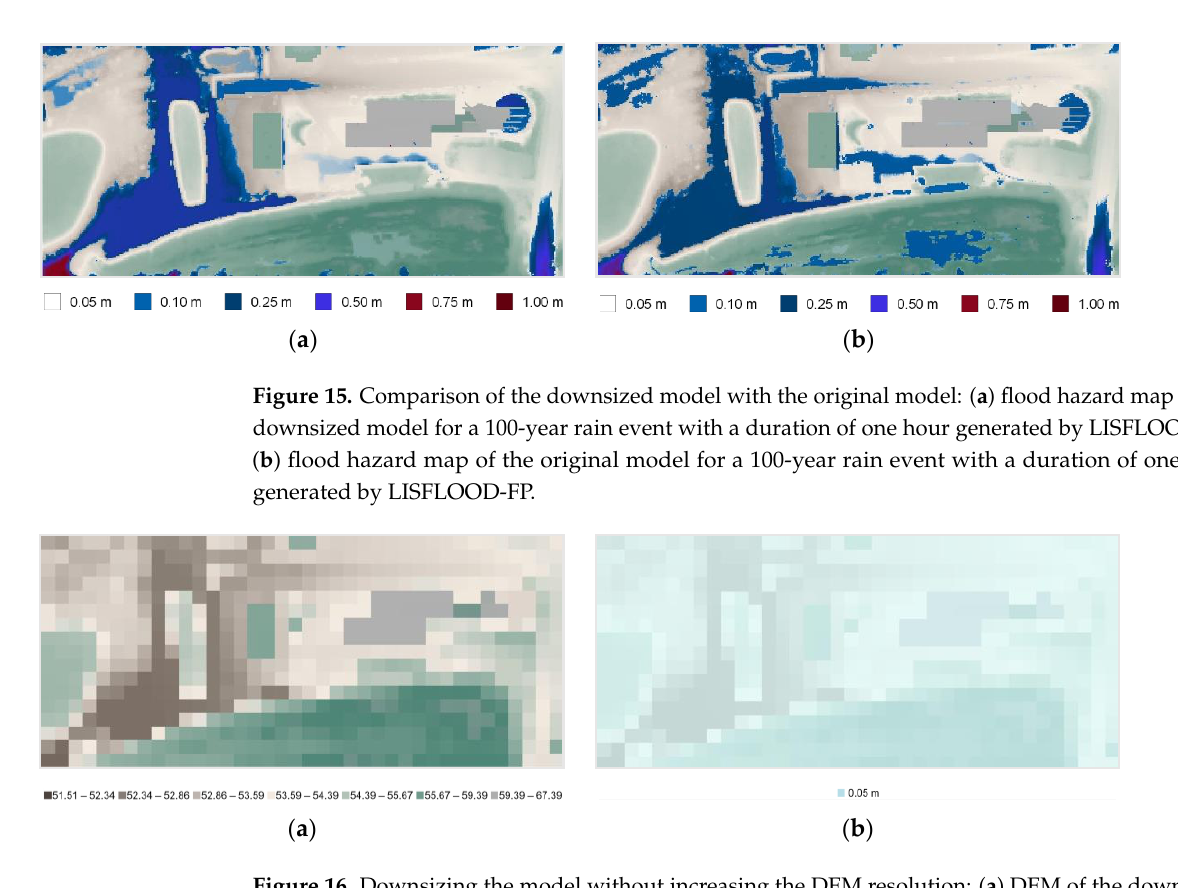
Figure 16. Downsizing the model without increasing the DEM resolution: ( a ) DEM of the downsized watershed with a resolution of one meter; ( b ) predicted hazard map for the downsized watershed with a DEM resolution of one meter.